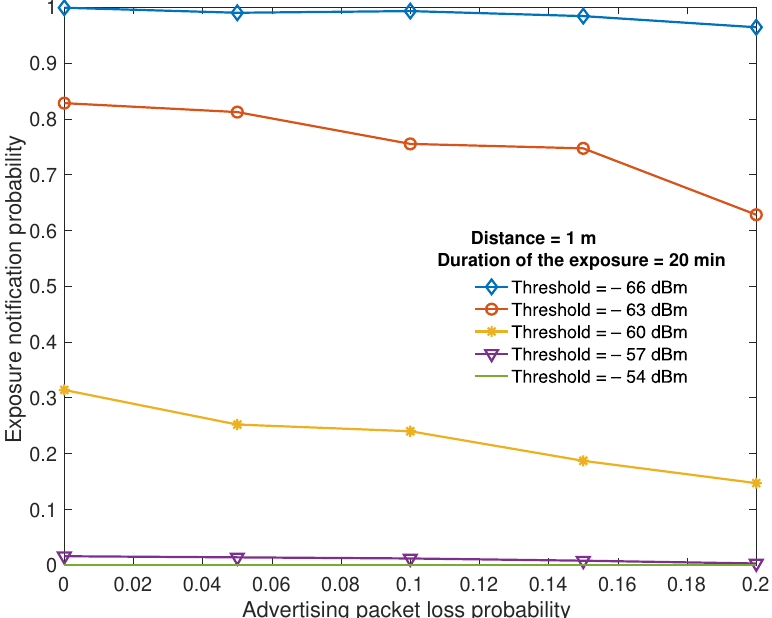
Figure 8. Probability of exposure notification vs. advertising loss probability at a proximity detector for a distance of 1 m and 20 min of